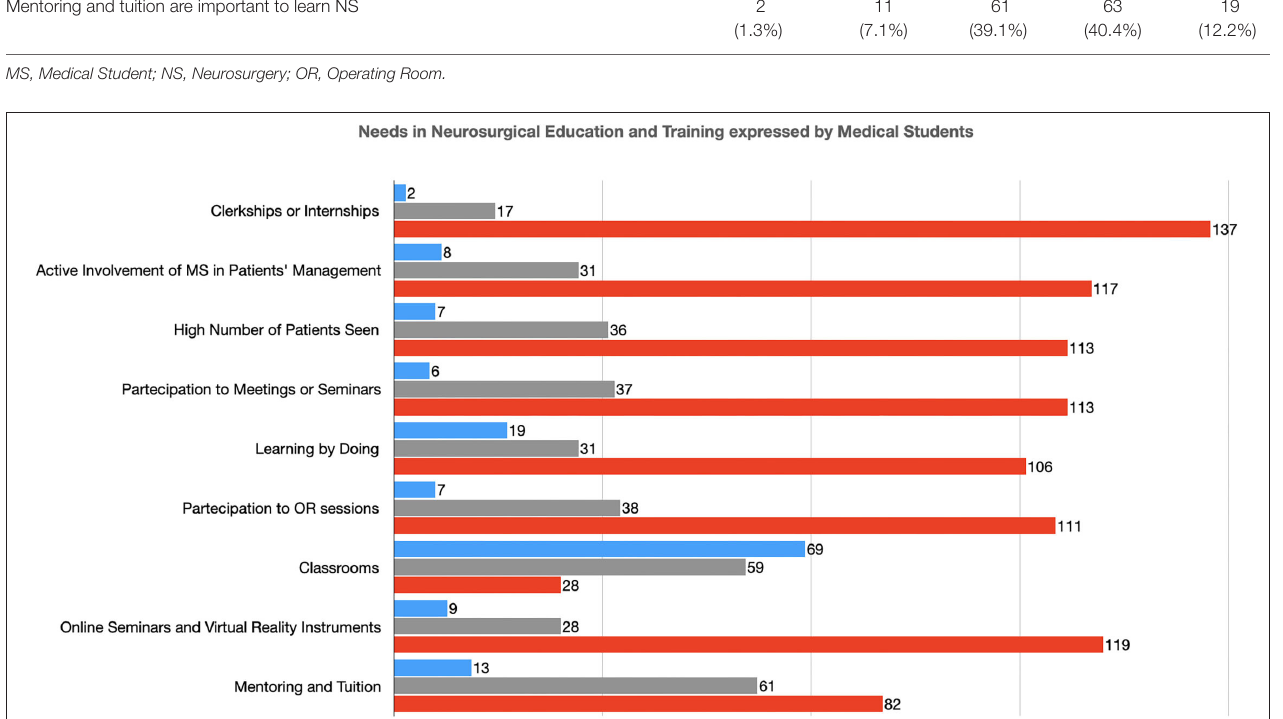
their association with the consideration of neurosurgery as a potentially interesting career ( Table 8